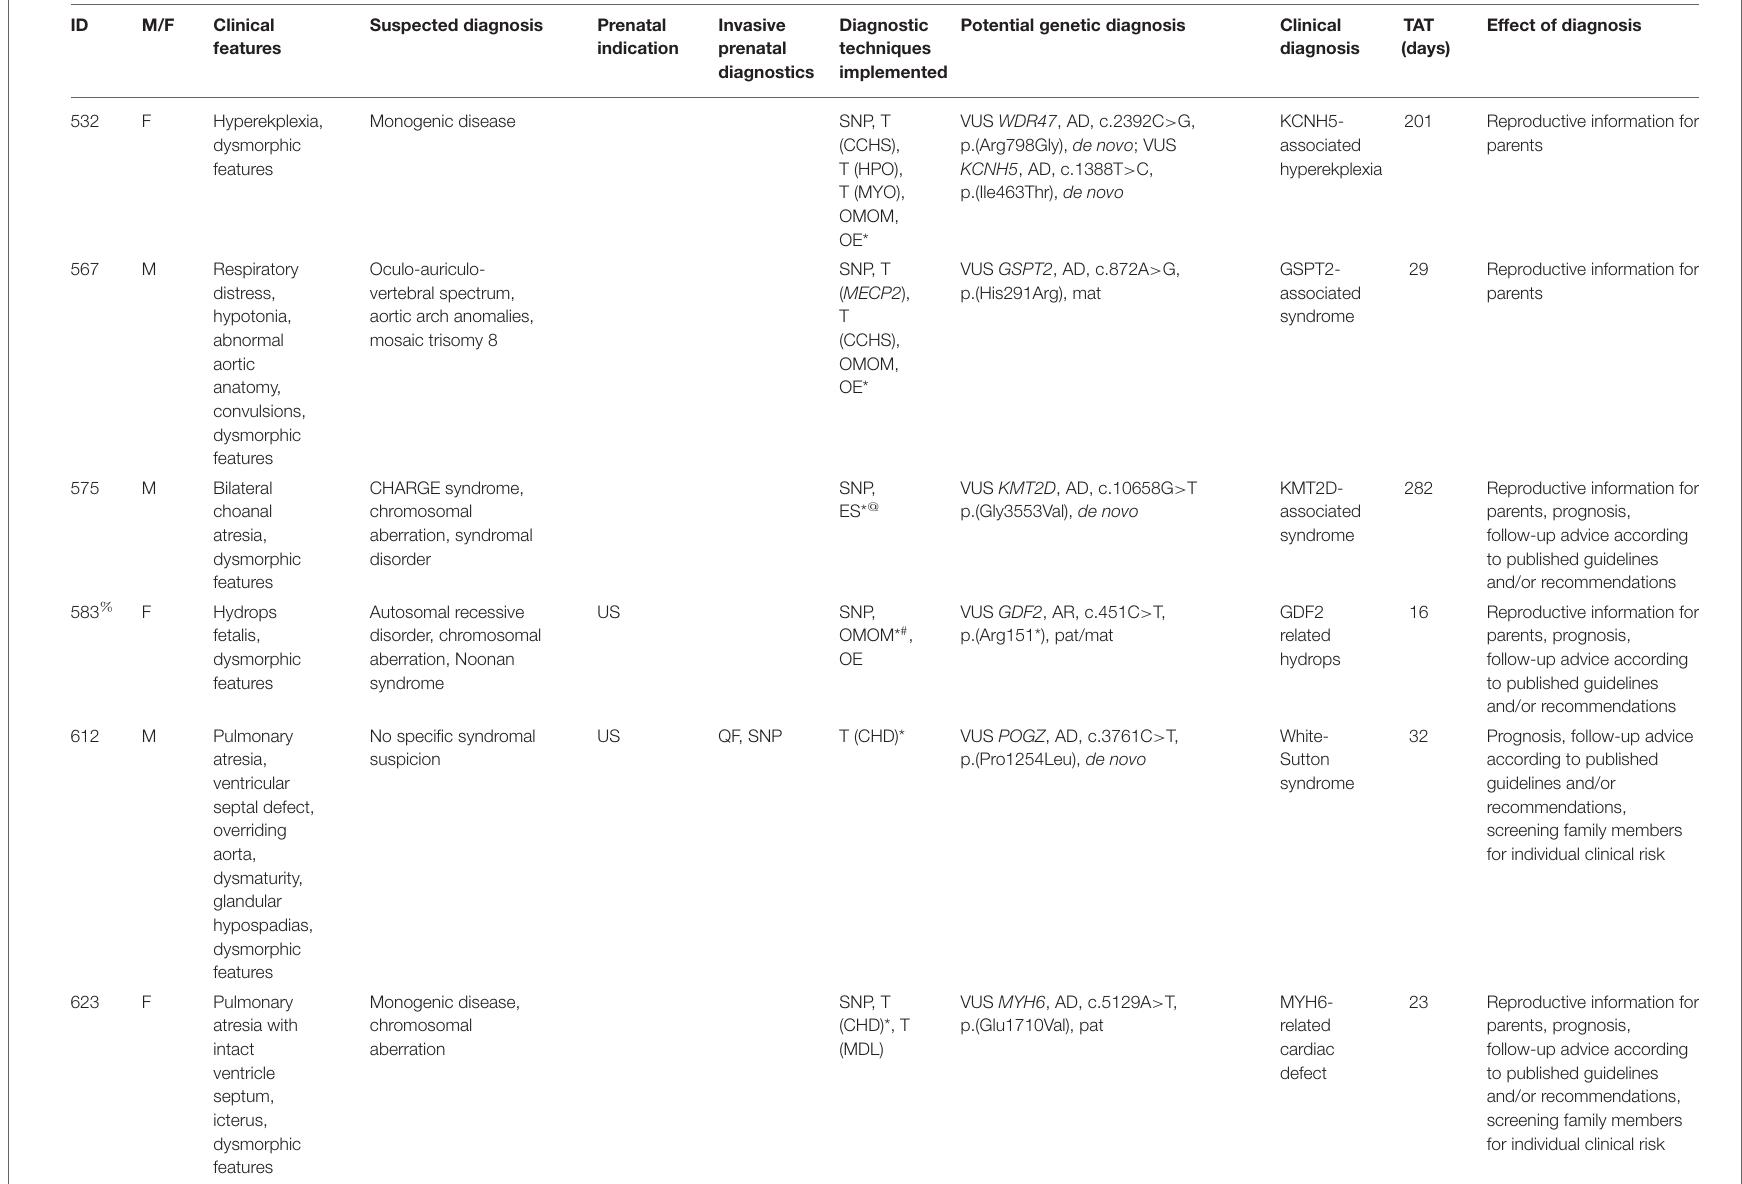
TABLE 4 | Reported variants of unknown